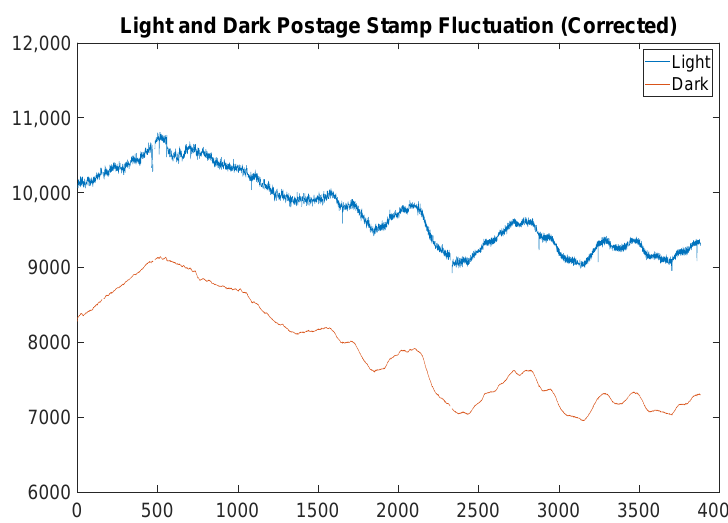
Figure 4. The above graph shows real light and dark postage stamp fluctuation over the time scale of a scan of the middle portion of the simulated munition after applying the filter prescribed in the Remark. For reference, the parameters used were a window length of 21, T rel = 2, T abs = 2, T perc = 0.03125.